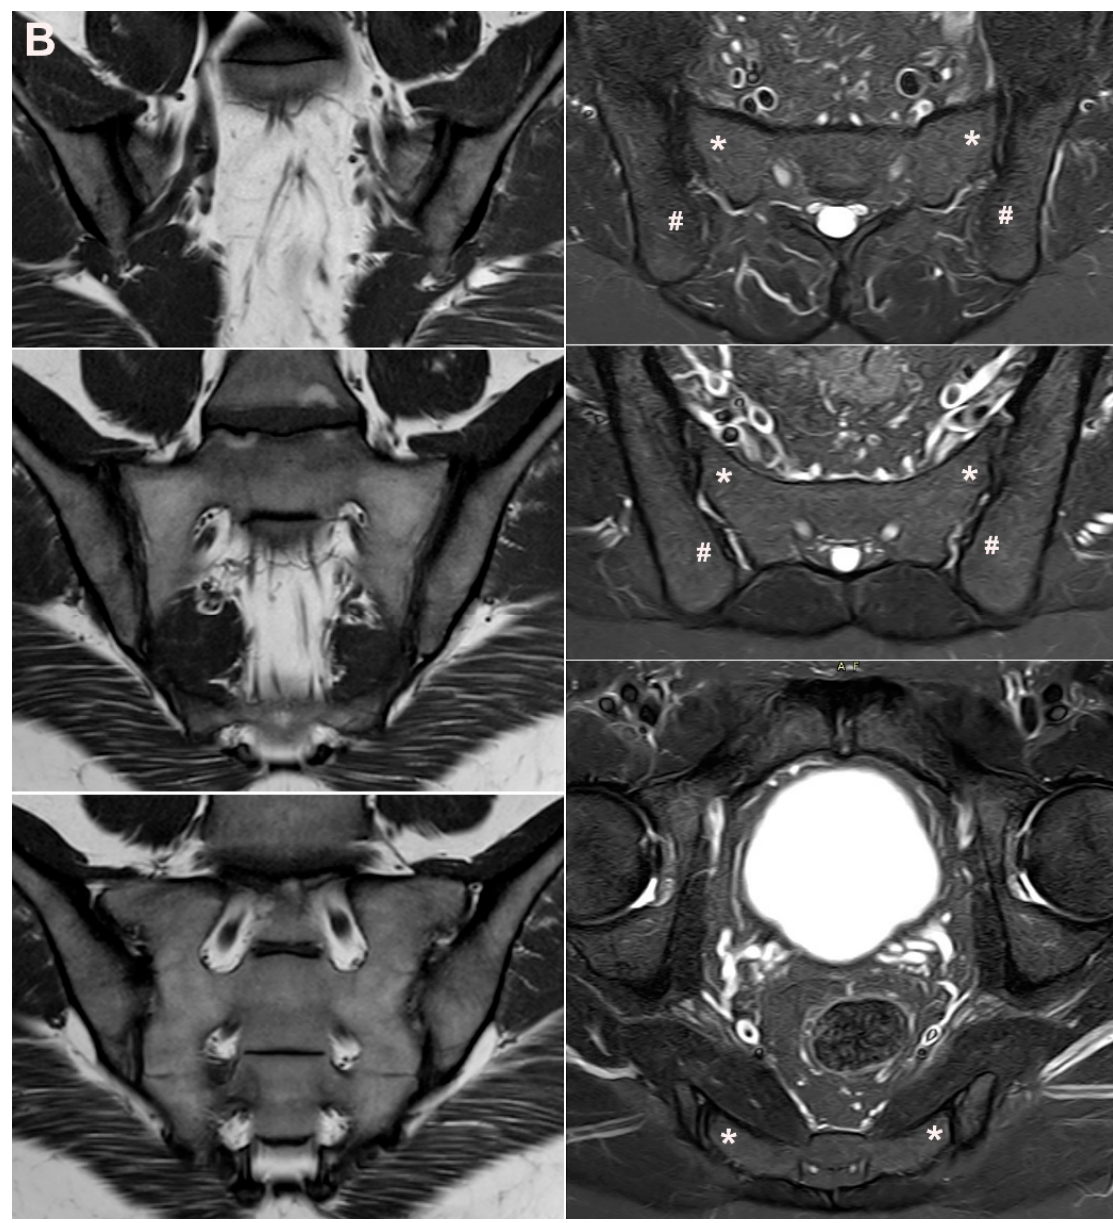
Figure 7. ( A ) Three-dimensional CT reconstruction of the sacral joint facet with lines corresponding to the two perpendicular scan planes, semi-coronal and semi-axial slice orientation, respectively. The semi-coronal slice orientation should be standardized to align the posterior margin of the second sacral vertebra or be perpendicular to the vertebral surface of S1. The scan volume should include the entire cartilaginous and ligamentous joint compartment, often implying slices outside the joint areas. ( B ) MRI of normal SIJs in a 31-year-old man with disk degeneration, three semi-coronal T1-weighted images, anterior, in the middle and posterior in the joint, and three semi-axial STIR images, at S1, S2, and S3 respectively, corresponding to the slice positions indicated on A and showing the anatomical localization of the different joint areas on the two perpendicular slice orientations. On the axial slices, the cartilaginous joint portion is marked with asterisks at the sacral side and the ligamentous portion with # at the iliac side of the joint. The axial image at S3 illustrate the use of a large field of view for semi-axial slices visualizing the upper part of the hips and the symphysis. On T1-weighted images there can be a patchy distribution of fat within the bone marrow with an increasing prevalence with increasing age, but not manifesting in